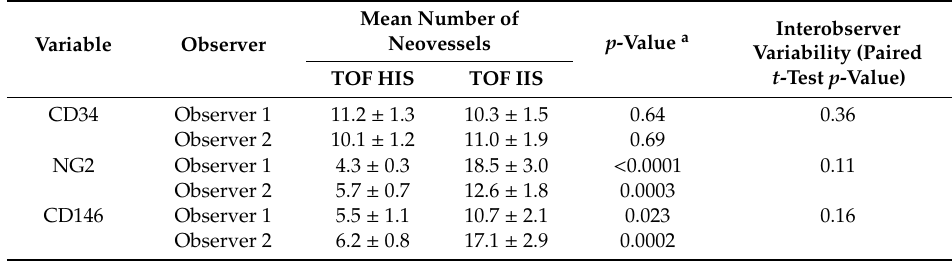
Table 3. Interobserver variability in the measurement of the number of neovessels.